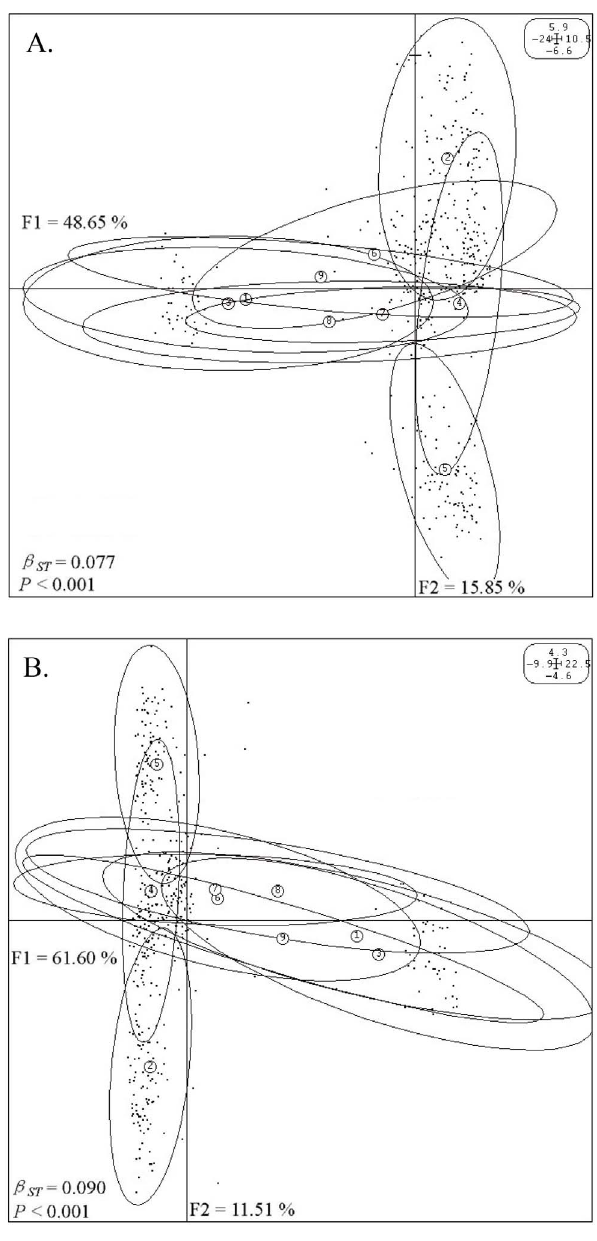
Figure 3. Eigen analysis between the nine natural populations of P . tomentosa using PCA values based on epigenetic covariance matrices. F1 and F2 values showed the contribution of the first two principal components summarizing the total variance of each data set. Numbers within circles represented populations of: (1) Beijing, (2) Hebei, (3) Shandong, (4) Henan, (5) Shanxi, (6) Shaanxi, (7) Gansu, (8) Anhui, and (9) Jiangsu. Ellipses represented projection boundary of each population. b ST were calculated by BPCA for epigenetic profiles and tested with 9999 Romesburg randomization permutations. ( A ) Eigen analysis between the nine natural populations of P . tomentosa using PCA values based on the MSP matrix. ( B ) Eigen analysis between the nine natural populations of P . tomentosa using PCA values based on the CG-CNG matrix.